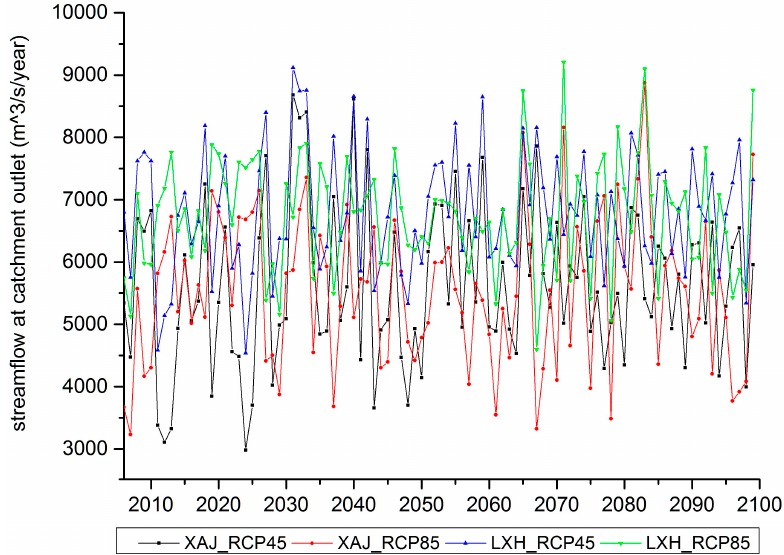
Figure 12. Comparisons of annual flow simulation under two climate change scenarios in two hydrological models.